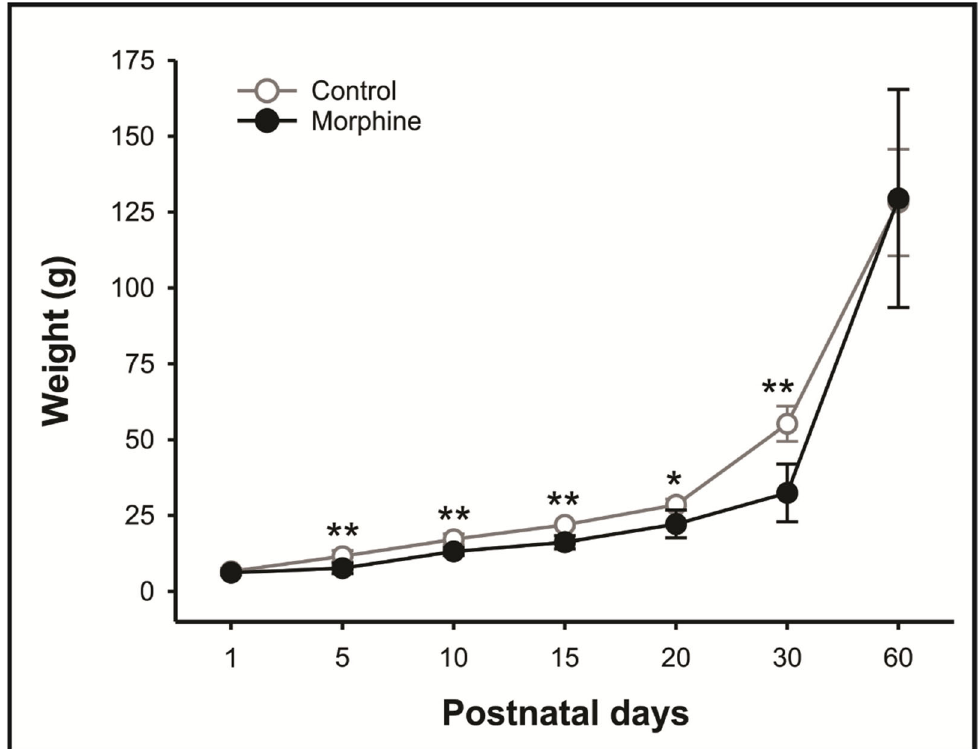
Figure 2. Effect of morphine treatment (10 mg/kg/day) during pregnancy and lactation on rat offspring body weight. Results expressed as mean ± S.D.M. ( n = 5). * p < 0.05 morphine vs. control group; ** p < 0.01 morphine vs. control group. Student ‐ t test.